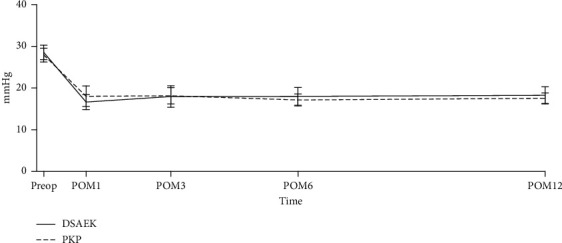
Intraocular pressures following MP-TSCPC in patients with history PKP vs. DSAEK.